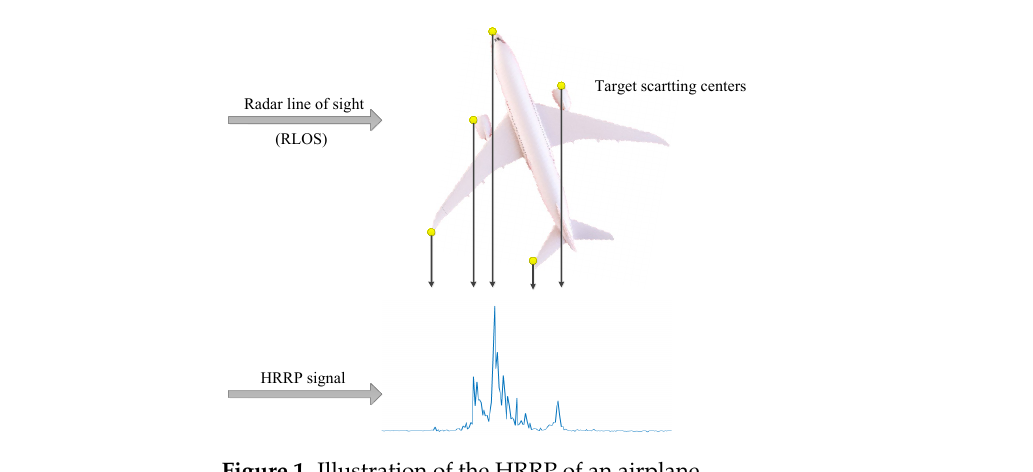
Figure 1. Illustration of the HRRP of an airplane.